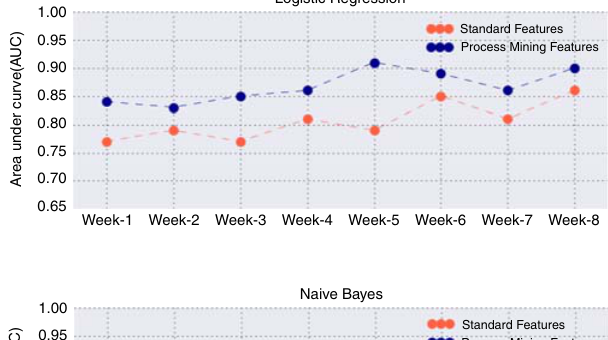
Figure 9. Comparative results of Naive Bayes method on the data set consisting of process mining features and without process mining features